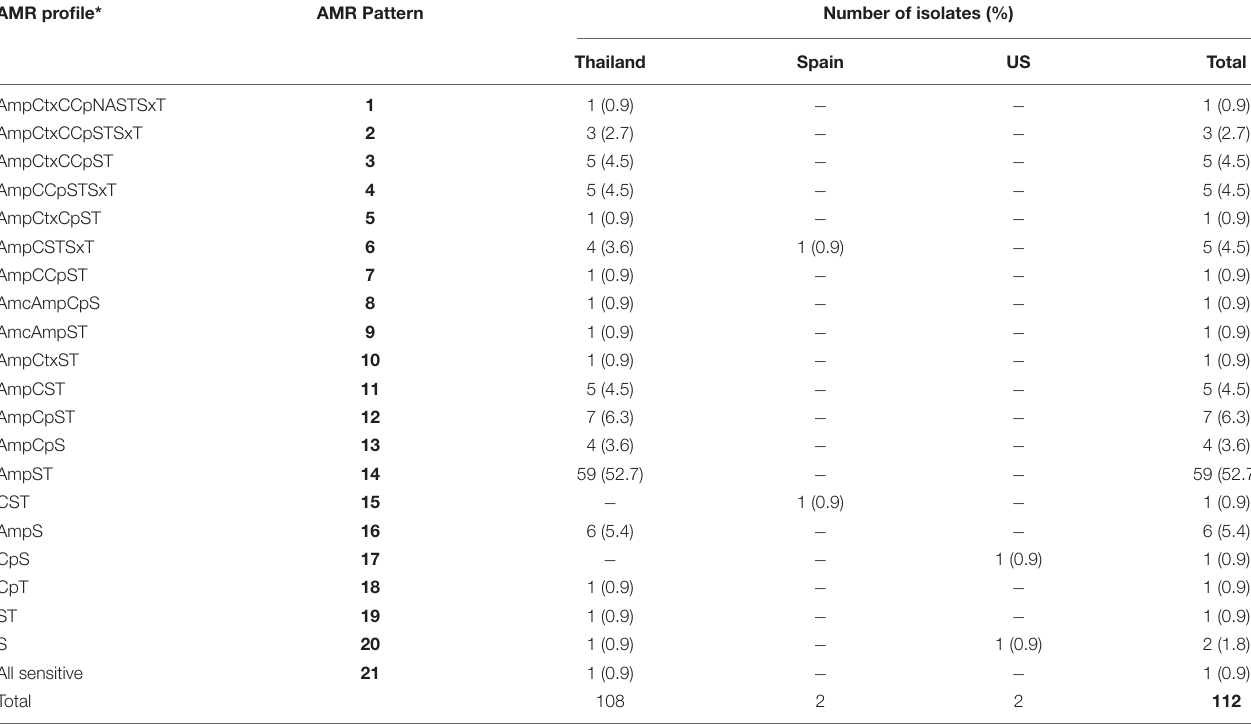
TABLE 2 | AMR patterns found in the study S. 4,5,12:i:- isolates ( n = 112). AMR